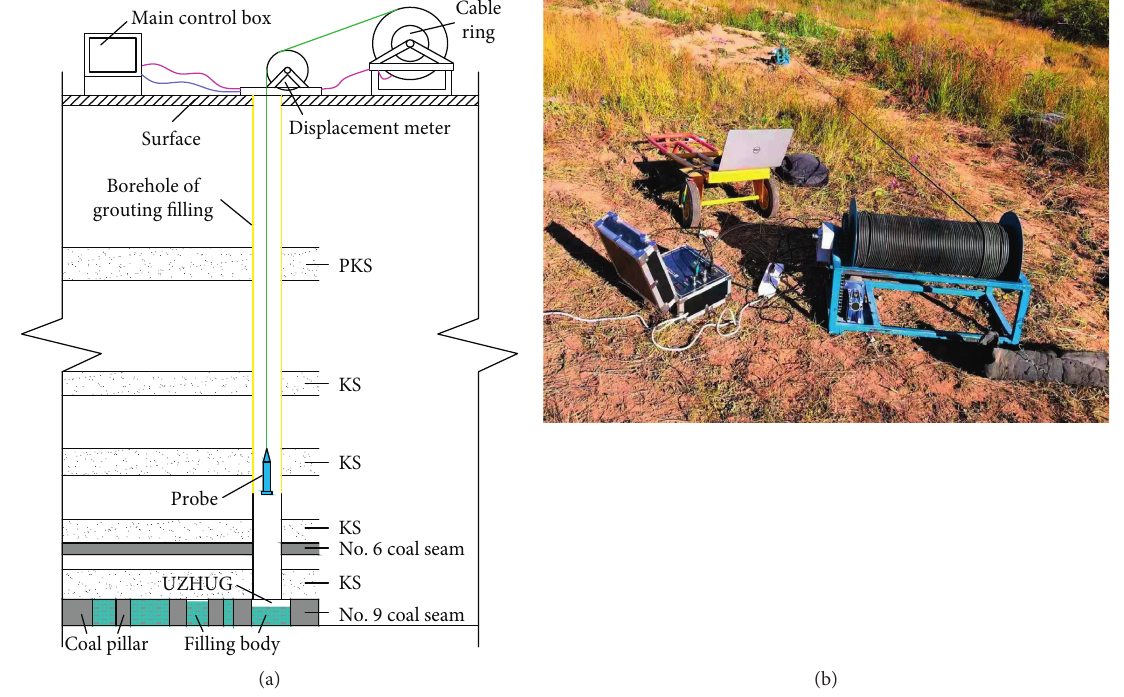
Figure 11: Field measurement indication and equipment